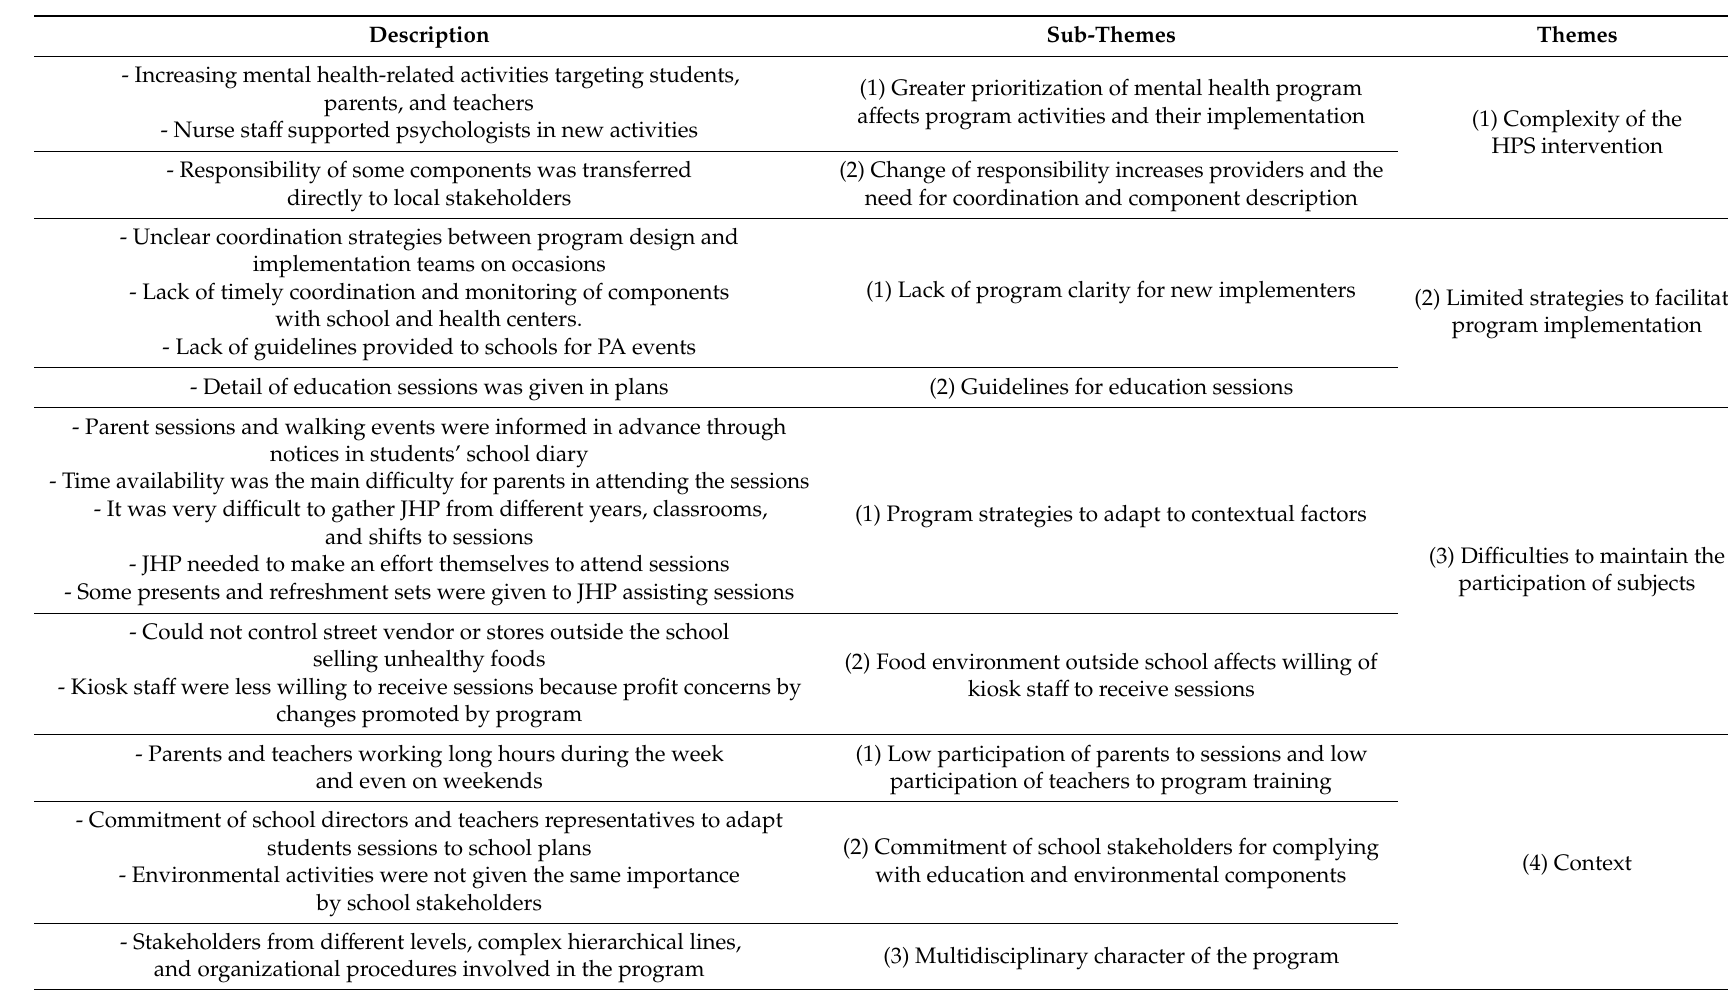
Table 6. Descriptions, Sub-themes and Themes Identified from the Qualitative Analysis on Factors A ff ecting Program